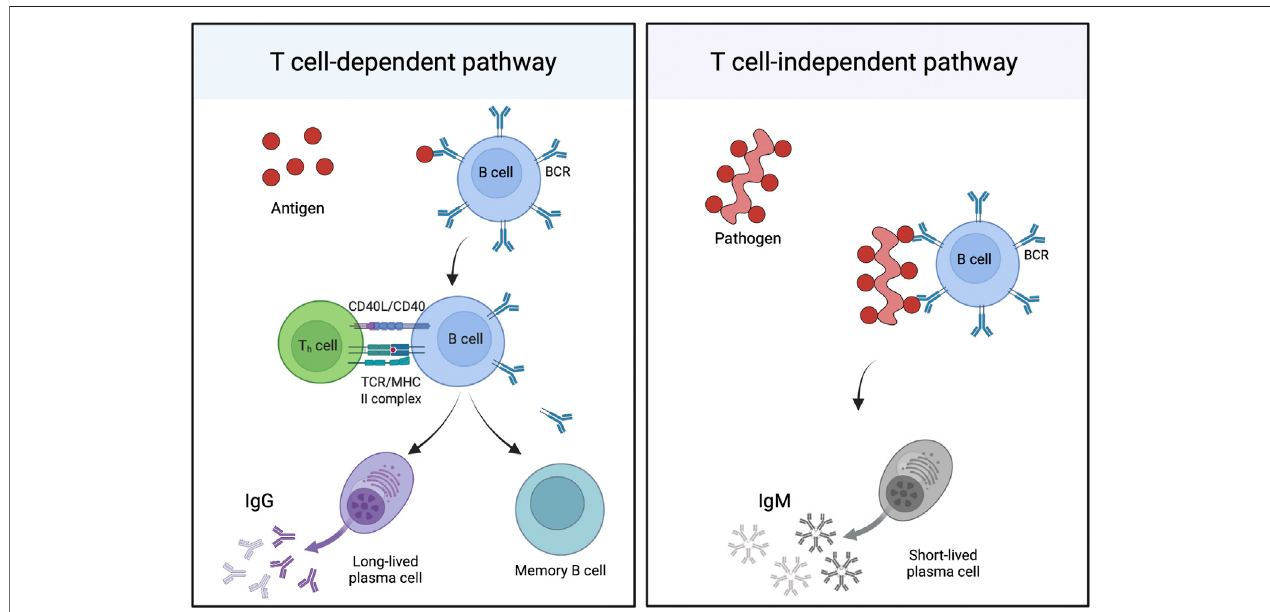
FIGURE4| Bcellactivation.Bcellscanbeactivatedprimarilythroughtwoways:theTcell-dependent(TD),ortheTcell-independent(TI)pathway.TheTDpathway (left) involves the binding of antigen to B cell receptors (BCRs) on the surface of B cells, internalization and digestion, then display of the resulting peptide on the B cell surfaceonmajorhistocompatibilitycomplex(MHC)IImoleculestoCD4 + Thelpercells.Antigen-speci fi cTcellswillthenbindtotheMHCusingtheirTcellreceptor(TCR). The CD40L and CD40 proteins on the T cell and B cell, respectively, will also bind, resulting in activation, proliferation, and maturation of the B cell into memory B cells and long-lived plasma cells, which produce IgG antibodies. The TI pathway (right) is activated by repetitive epitopes on the surface of a pathogen, which heavily crosslink the BCRs on the surface of the B cell. This most often results in B cell activation, maturation, and the generation of short-lived plasma cells, which primarily produce IgM. This fi gure was generated using